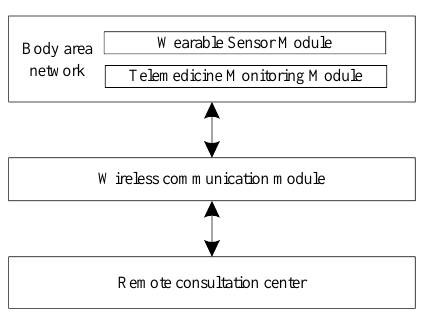
Figure 1. Overall structure of the system